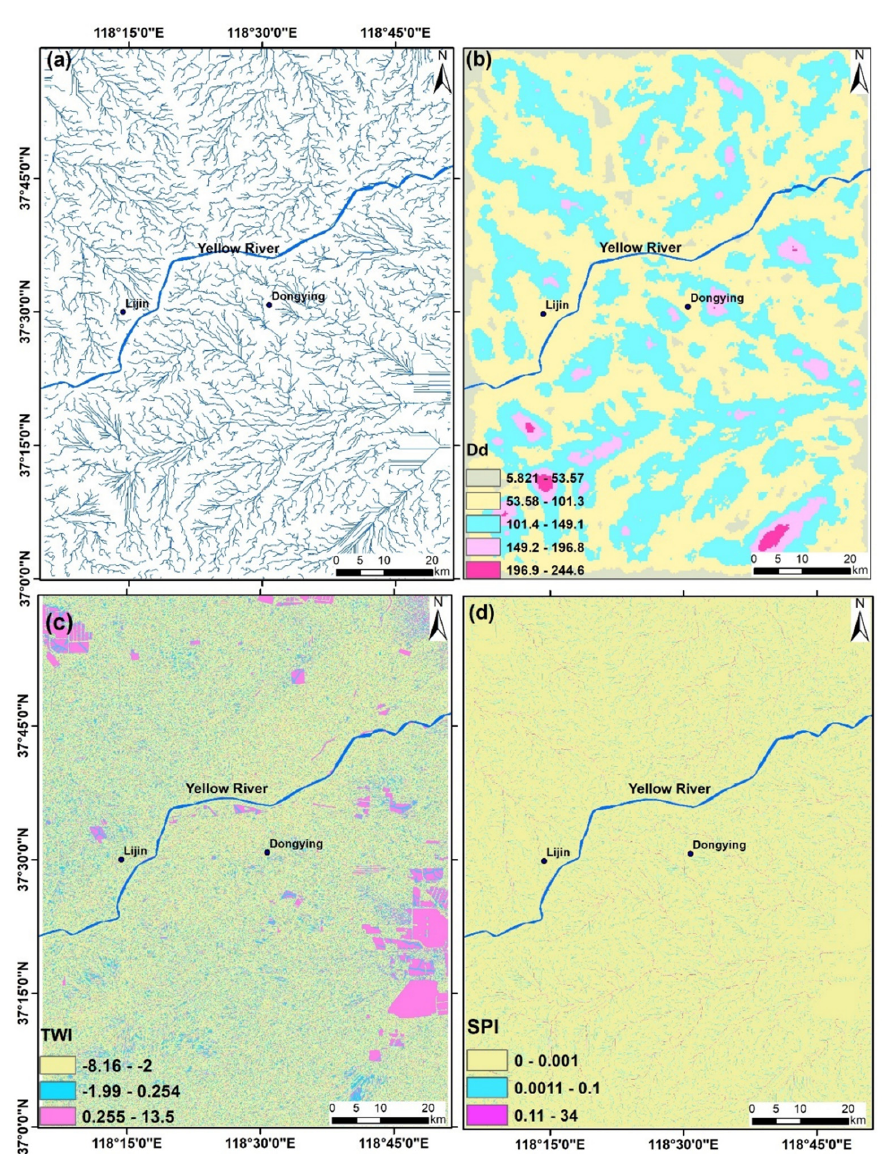
Figure 4. ( a ) Stream networks; ( b ) drainage density; ( c ) TWI; ( d ) SPI.